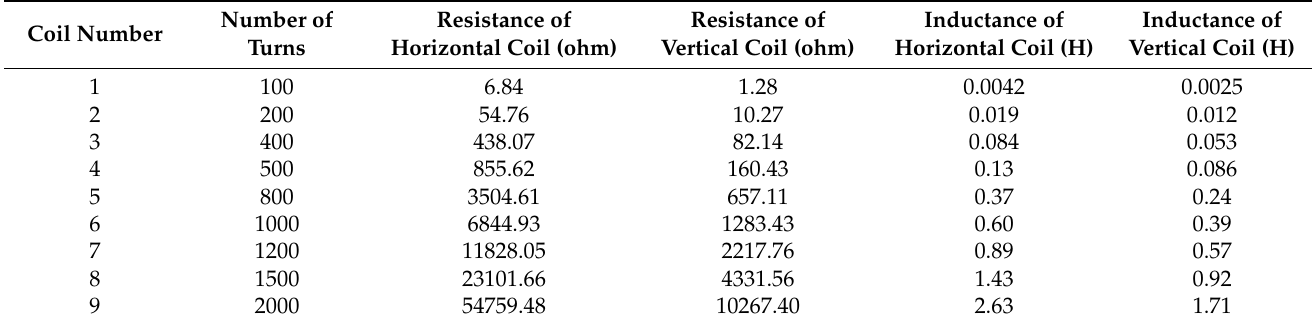
Figure 15. Surface evolution and magnetic flux density arrow surface for case 1, near resonance frequency for L = 5 cm tank. Table 5. Summary of properties of coils for L = 5 cm